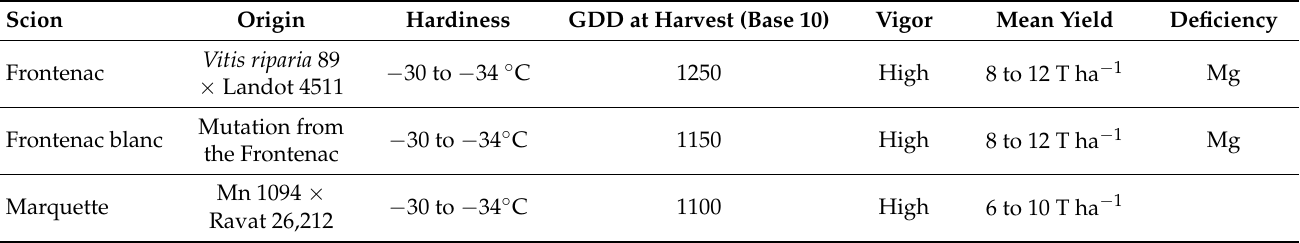
Table 1. Characteristics of grape